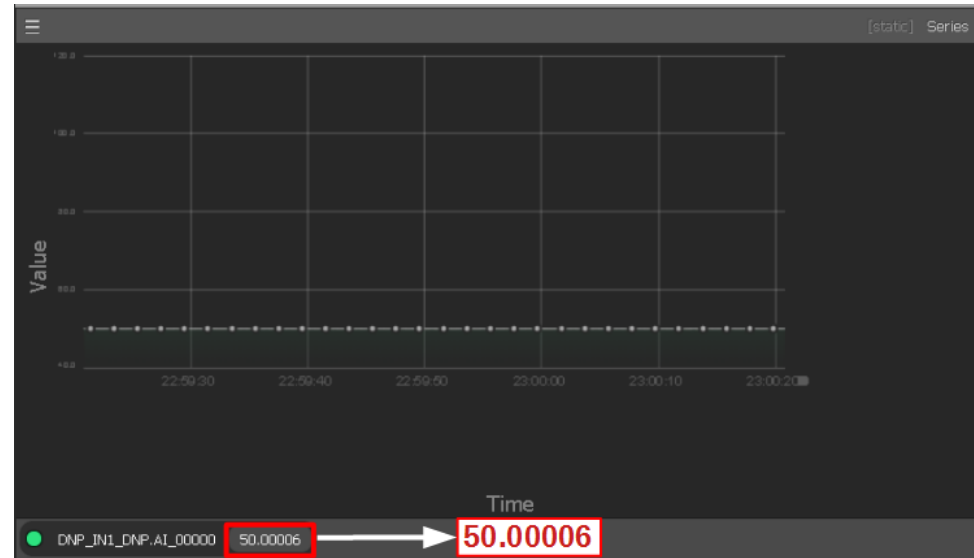
Figure 15. Real-time values of frequency (Hz) in